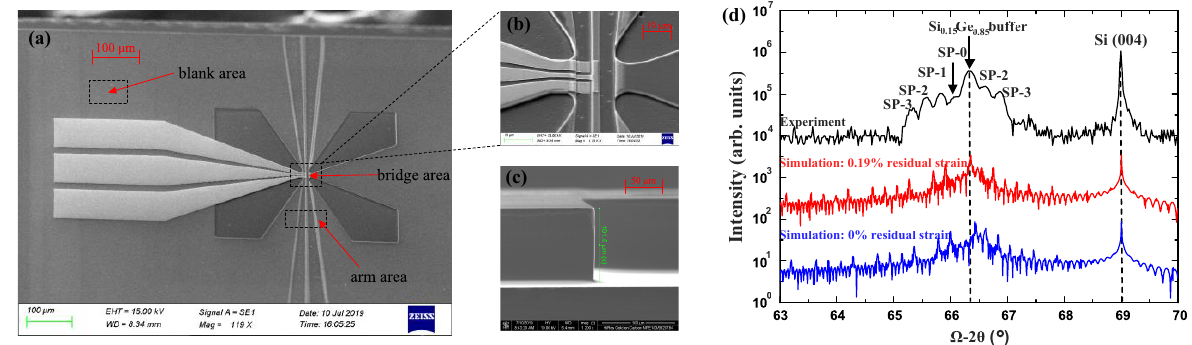
Figure 3: (a) SEM image of the fabricated device with suspended microbridge and deep etching facet after splitting. (b) Detailed image of the active area. (c) Deep etching facet of the coupling end. (d) X-ray diffraction (XRD) experiment and simulations of the wafer after